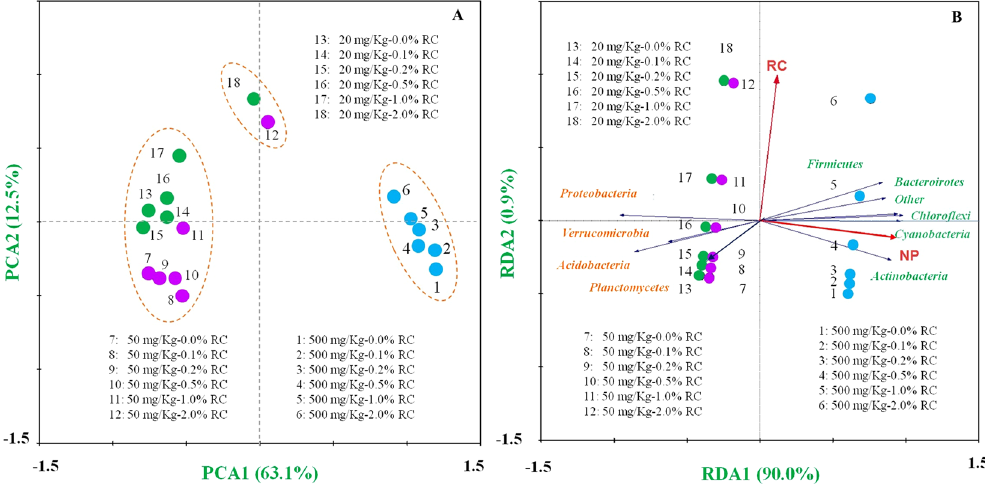
Figure 5. Cluster ( A ) and RDA ( B ) analysis at genus